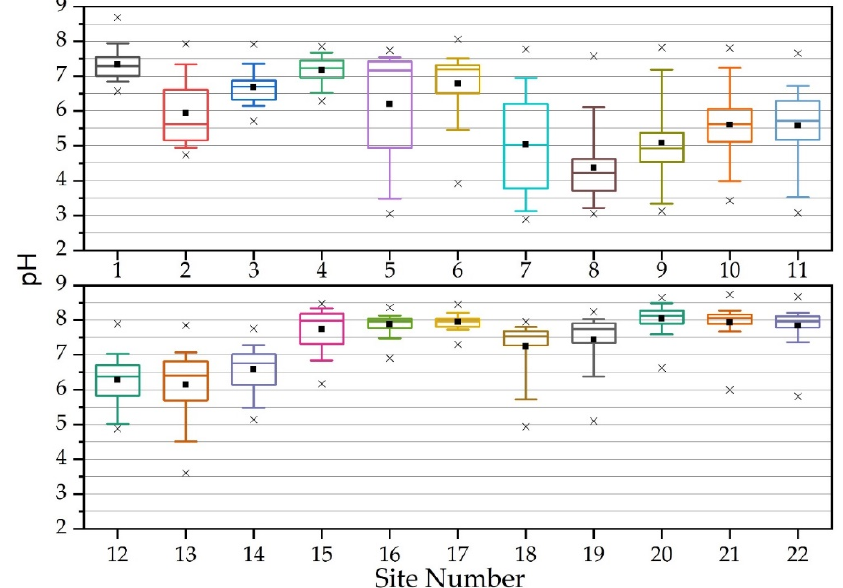
Figure 5. Box and whisker plot of pH descriptive statistics at 22 sampling locations during study period (2 January 2018–1 January 2019) in West Run Watershed, Morgantown, WV, USA. Box delineates 25th and 75th percentiles; line denotes median; square shows mean; whisker describes 10th and 90th percentiles; x shows maximum and minimum when above and below, respectively.